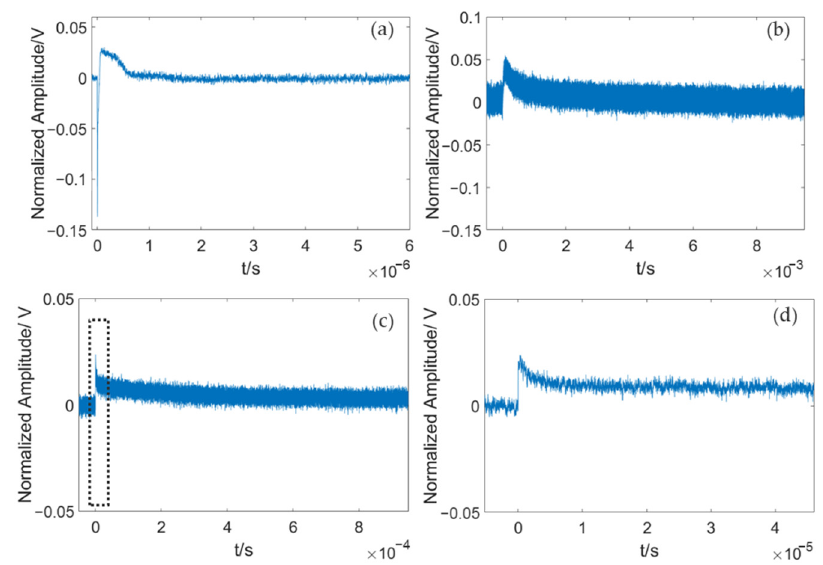
Figure 10. Temporal experimental time-domain results between different interfaces: ( a ) agarose gel and copper; ( b ) agarose gel and aluminum; ( c ) agarose gel and carbon fiber; and ( d ) the curve within 45 µs of ( c ).